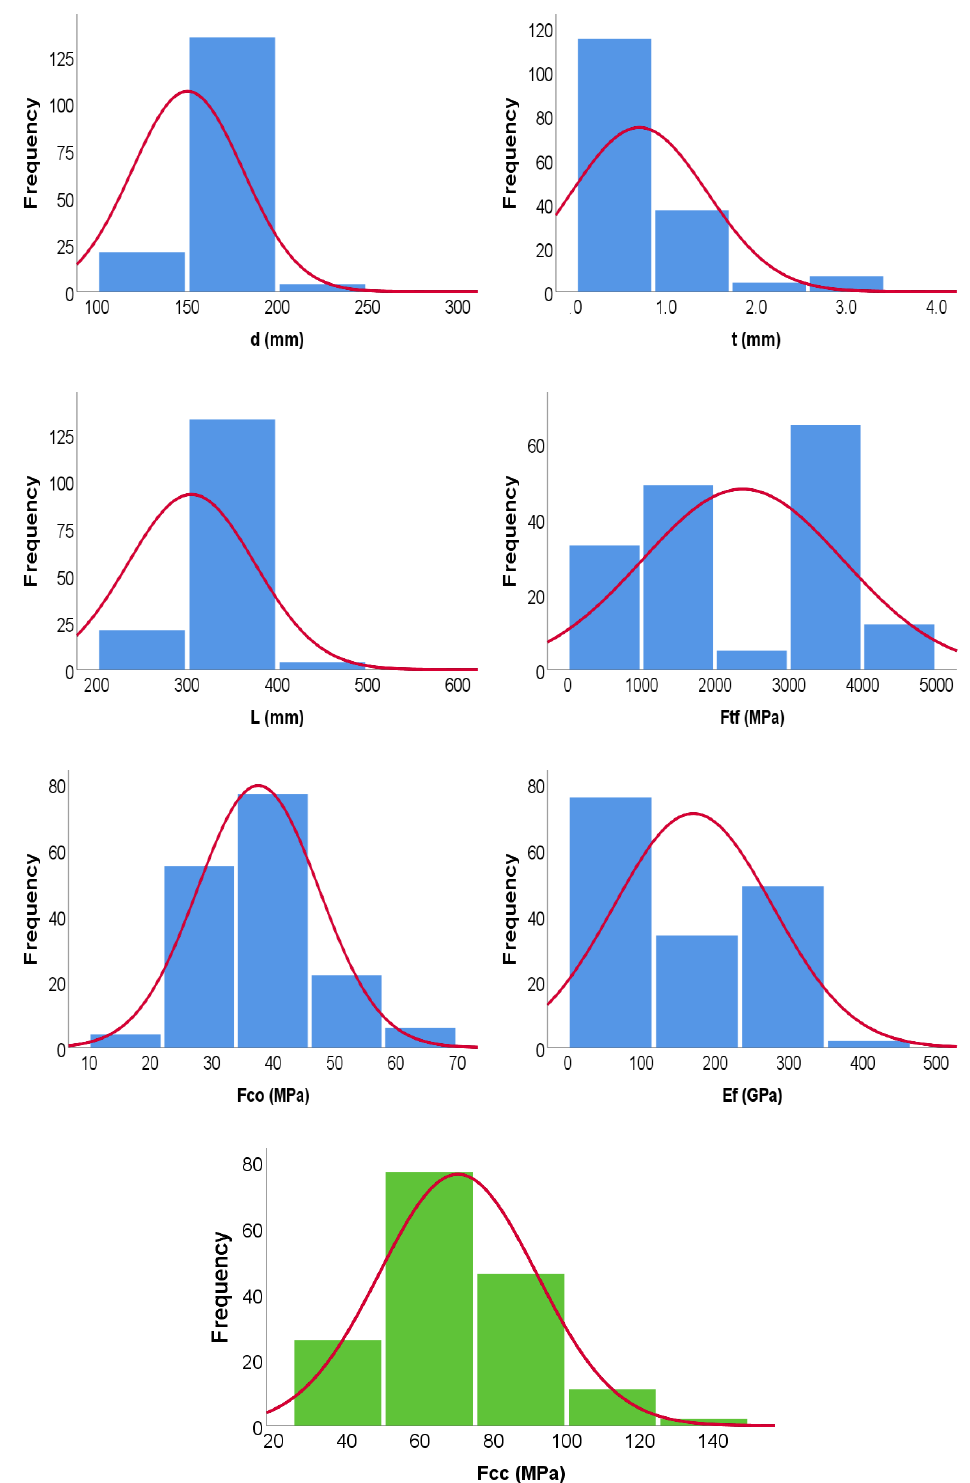
Figure 2. Variables ’ histograms, outputs (green), and inputs (blue). Figure 2. Variables’ histograms, outputs (green), and inputs